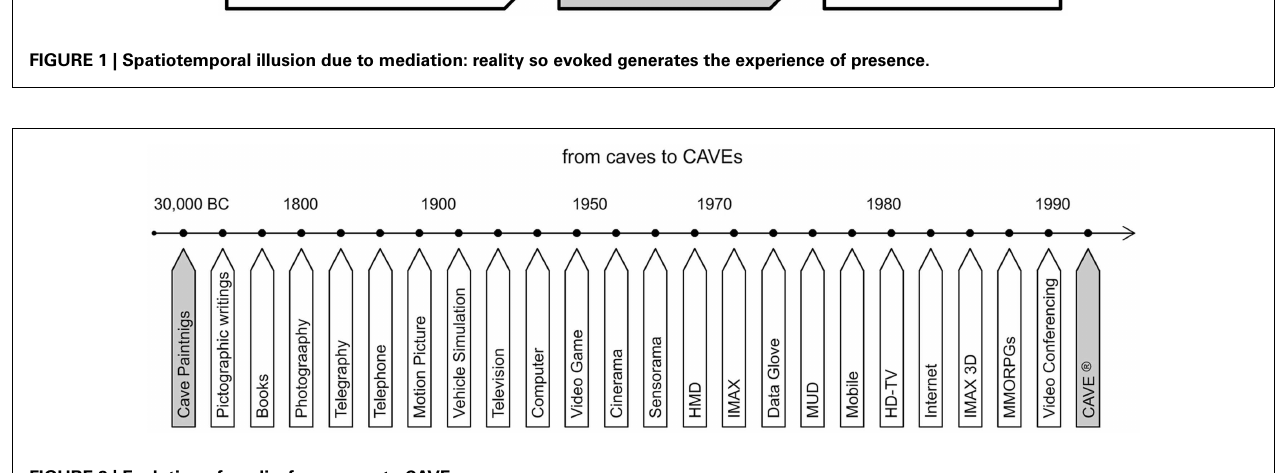
FIGURE 2 | Evolution of media: from caves to